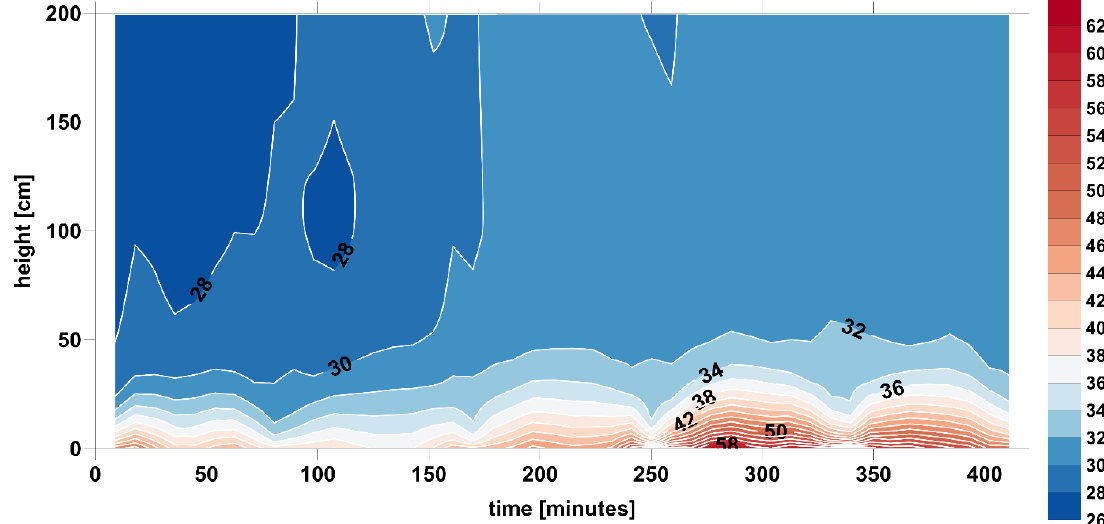
Figure 8. Temperature (°C) of common artificial urban surface asphalt and adjacent air during a cloudless tropical day. Axis x shows time from the point when the AT at 2 m at reference station reached 30 °C (approximately at 8 a.m. in this particular case).